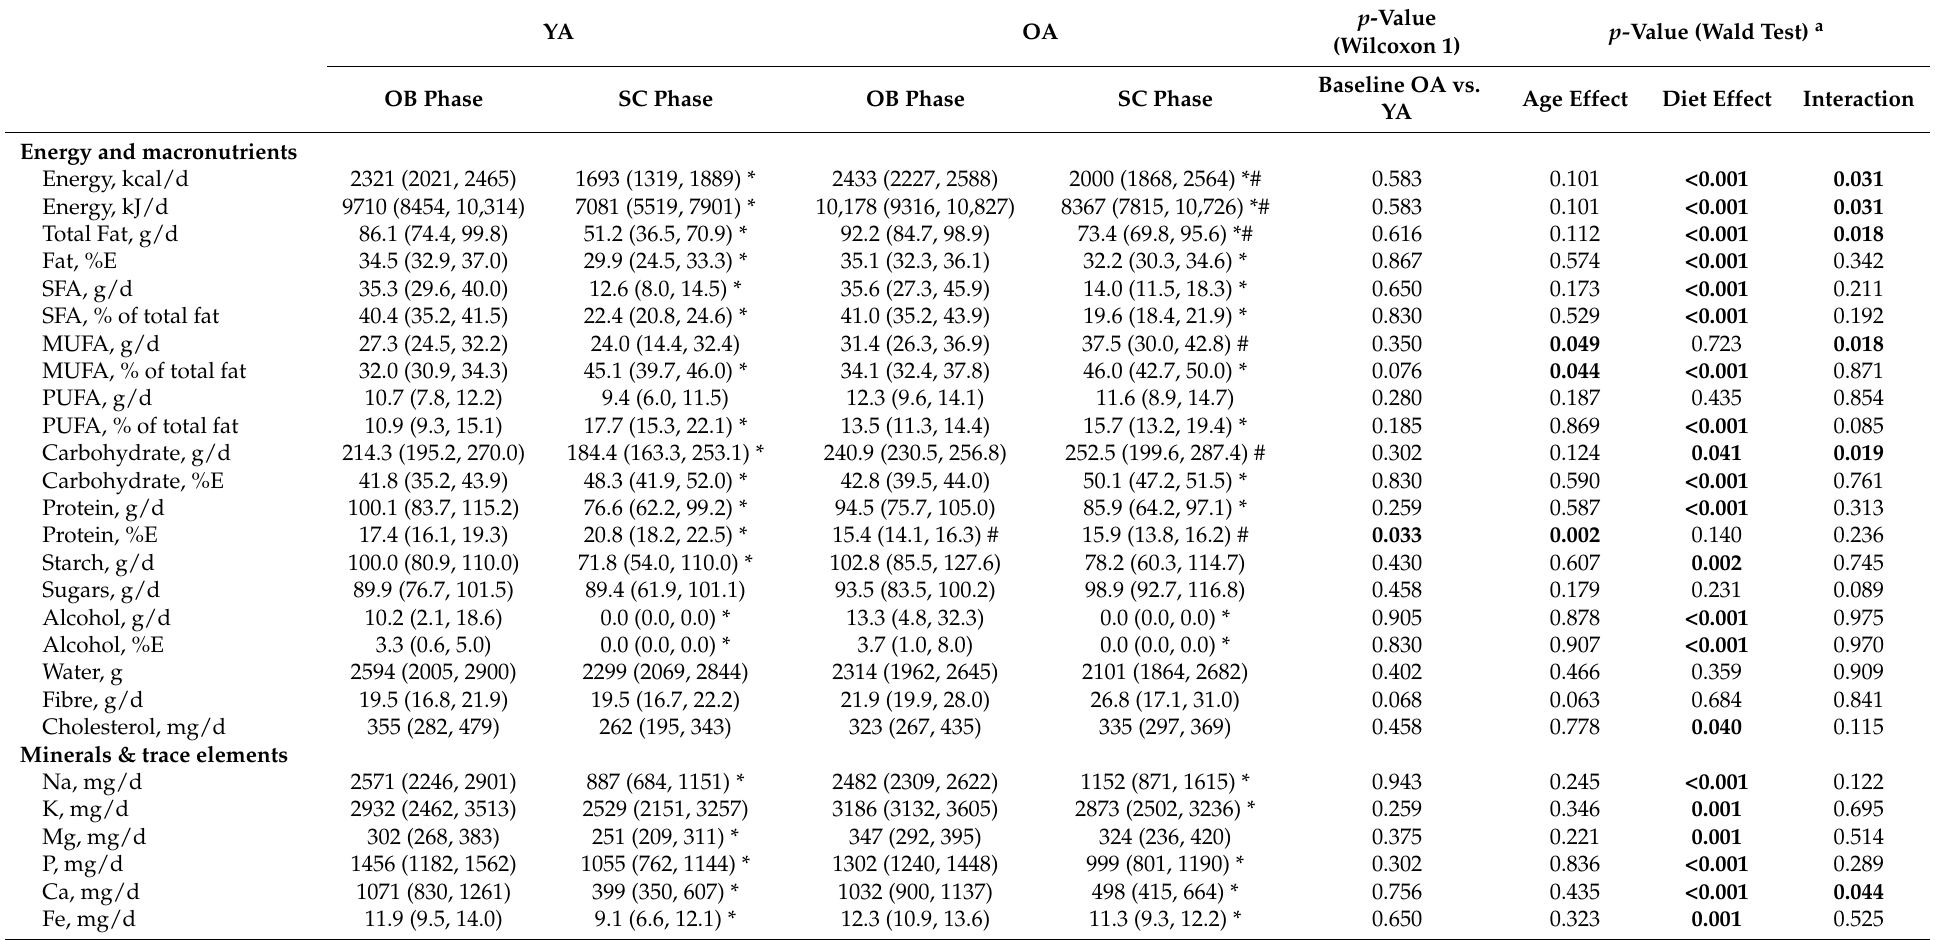
Table 2. Energy, macro- and micronutrients intake (median (IQR)) during observation and semi-controlled diet periods in young and older